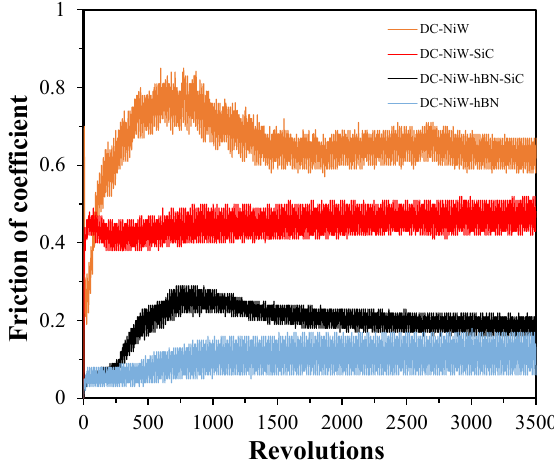
Figure 10. Coefficient of friction for the respective DC electrodeposited of NiW, NiW–SiC, NiW– hBN, and NiW–hBN–SiC electrodeposited from an optimized electrolyte on the brass substrate for 3500 revolutions at room temperature and normal applied load of 1 N. Coatings 2022 , 12 , x FOR PEER REVIEW